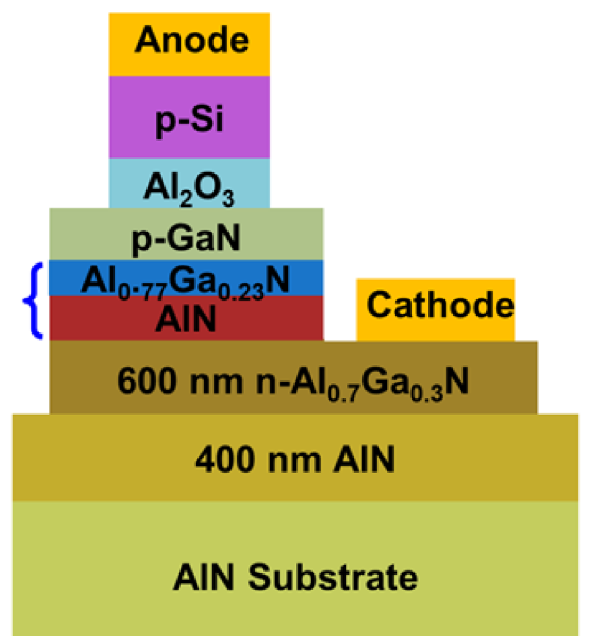
Figure 5. UV-LED fabrication process illustration. An optical microscopic image of fabricated LED. [17] Copyright 2018, AIP